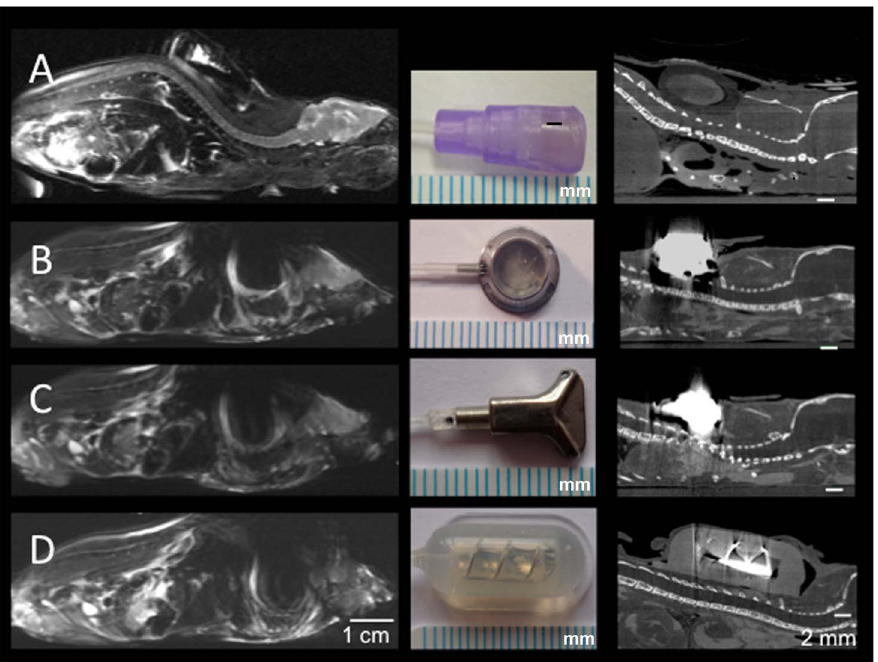
Figure 4. Assessment of port-induced artifacts in mice using a high field strength MRI (dedicated small animal scanner at 9.4 T; T2- weighted sequence) and micro-CT. Whereas the custom-made vascular access mini-port (A) does not cause any relevant artifacts in MRI or micro- CT imaging, all commercially available mini-ports (B: SoloPort MICRO, C: Microport, D: Penny MousePort) cause strong susceptibility artifacts at 9.4 T that hamper proper imaging of mice. In micro-CT, artifacts of the commercially available mini-ports only interfere with thoracic imaging (or other regions, depending on the site of port implantation). Scale below the photographs: 1 mm.